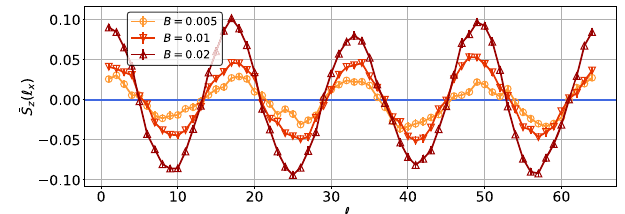
FIG. 14. Row-averaged real-space staggered spin density ¯ S k Þ l l z ð x Þ versus x with different amplitudes of the input spin spin ð perturbation. A 64 × 4 lattice is used with U=t ¼ 8 , δ ¼ 1 = 8 , and β ¼ 20